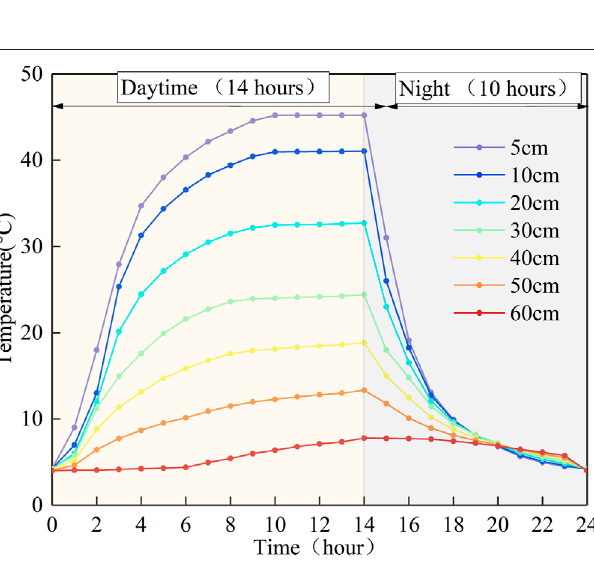
FIGURE 10 | The temperature variation in soil column in a temperature